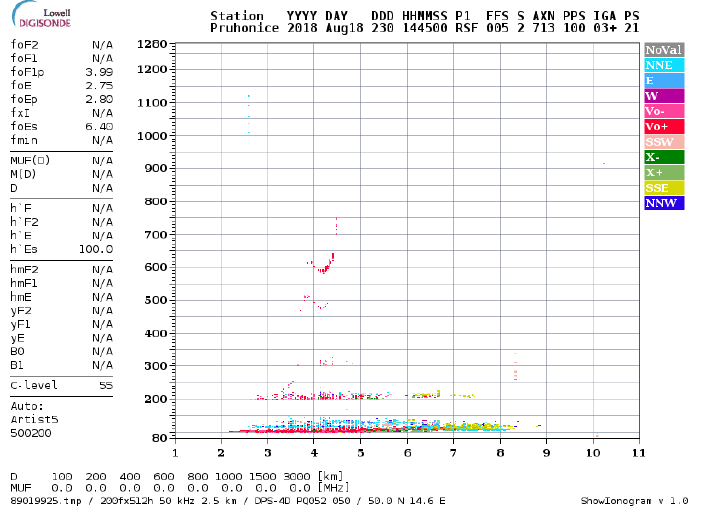
Figure 6. Pruhonice ionosonde plot 18 August 2018, 14:45 UTC. Intense Es reflections (horizontal trace) can be seen at around 100 km virtual height, with a second bounce (via ground) at 200 km.